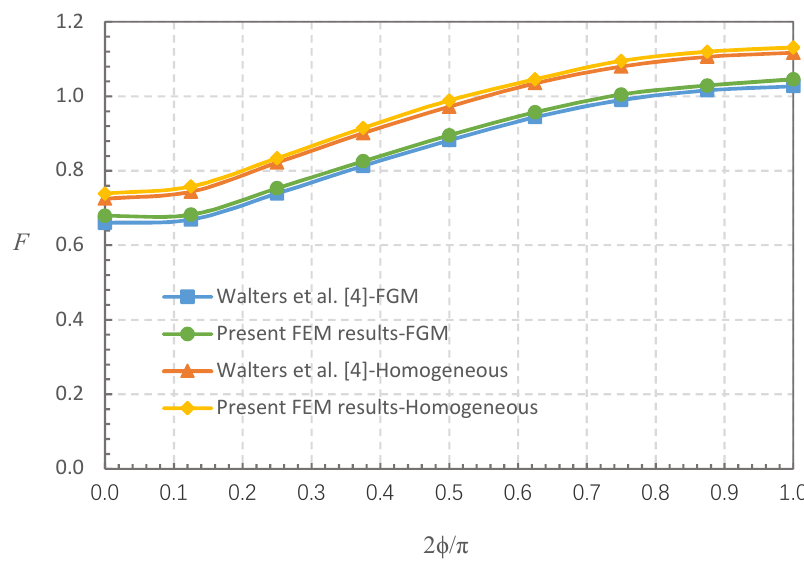
Figure 3. Comparison of BCFs ( F ): finite element method (FEM) results in this study vs. results in reference [4], for a / t = 0.2, a / c = 1/3, E (1)/ E (0) = 0.2, and homogeneous material.